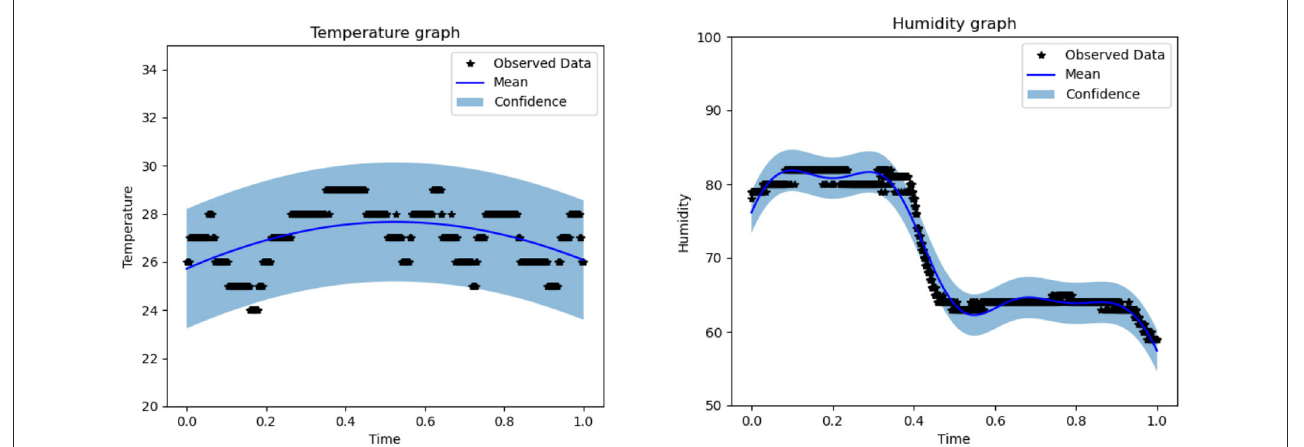
FIGURE6 Temperature (left) and humidity (right) boundaries for the forecasting